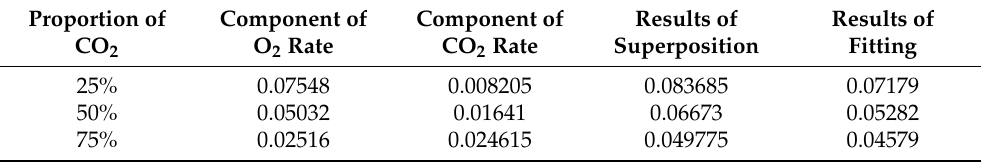
Table 7. Comparison between results of linear superposition and results of fitting. Proportion of Component CO 2